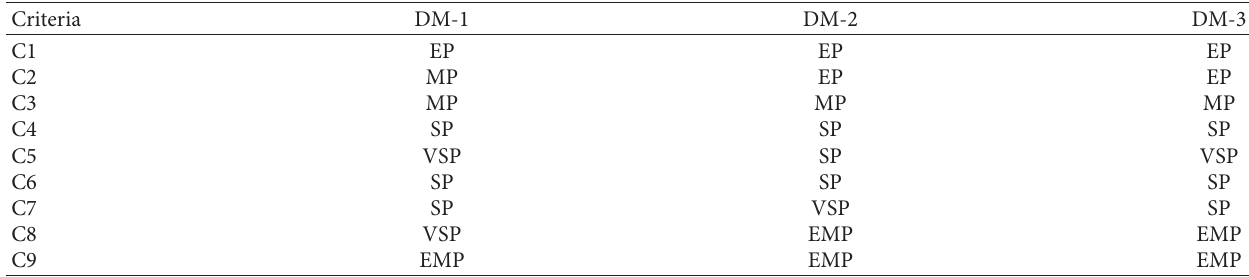
Table 5: Decision-makers’ linguistic preferences for the best criterion with regard to each of the other criteria (best-to-others vector). Criteria